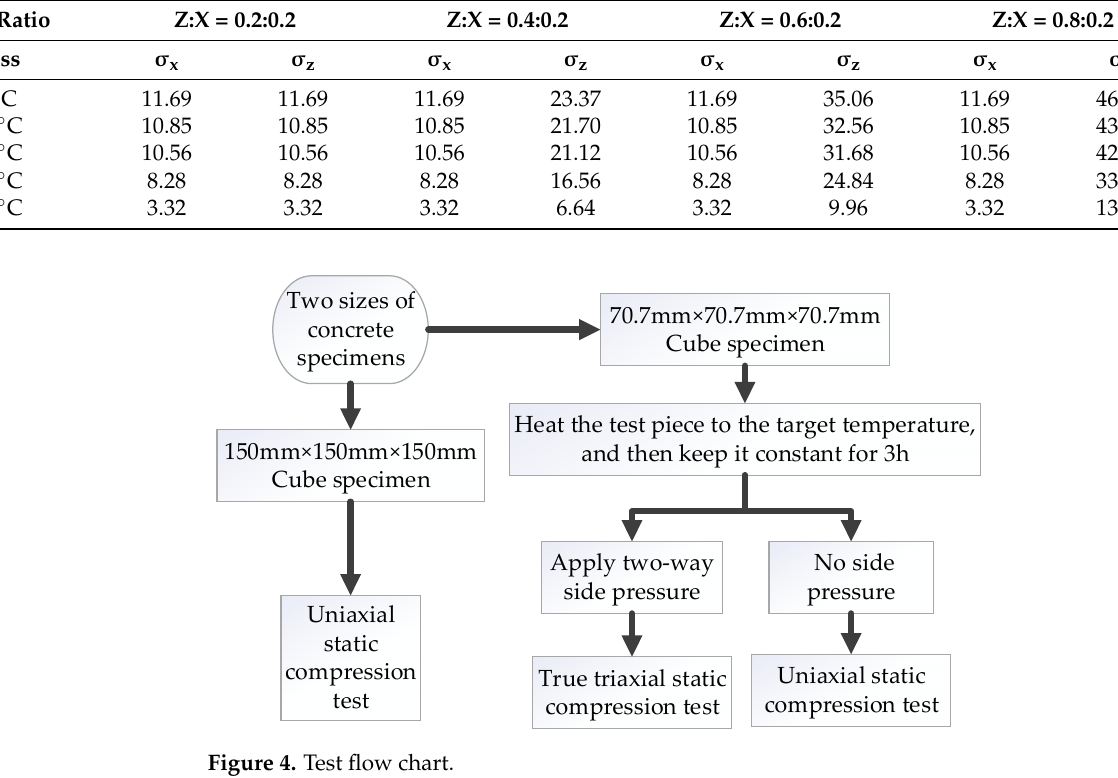
Table 5. Side pressure setting of true triaxial test (unit: MPa).